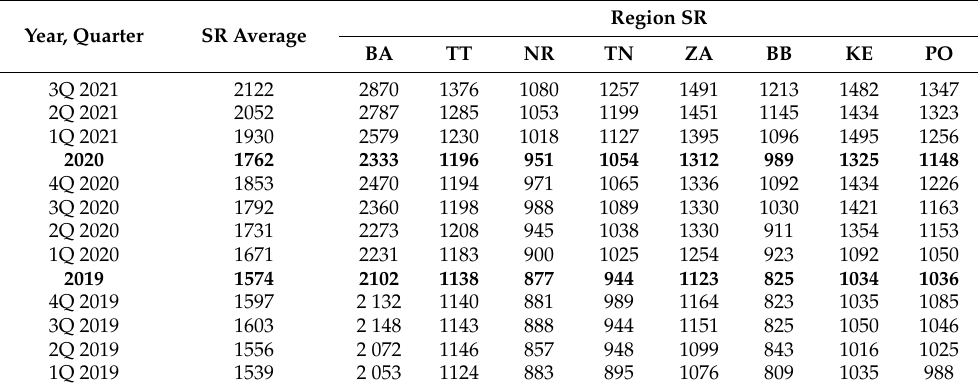
Table 3. Housing real estate prices: by region of the Slovak Republic [31]. Region SR Year, Quarter SR Average BA TT NR TN ZA